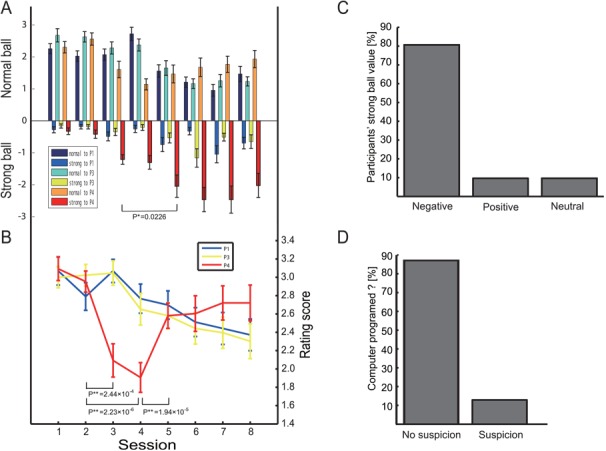
Player behaviors and ratings, and post-experiment questionnaires. (A) Bar graphs show the mean ball types (normal or strong) per session. Normal balls are shown in the positive region and strong balls in the negative region. From session 3 to session 5, the number of strong balls thrown by P2 to P4 increased significantly (F (2,42) = 3.32, P < 0.05), showing the effect of conformity. (B) Participants’ ratings of the other players. In session 3, the rating of P4 significantly decreased compared to the rating in session 2 (one sample t-test, P = 2.44 × 10−4). Error bars represent standard errors. (C) More than 80% of participants felt negatively toward strong balls. (D) Almost 90% of participants did not suspect that other players were computer-programmed.